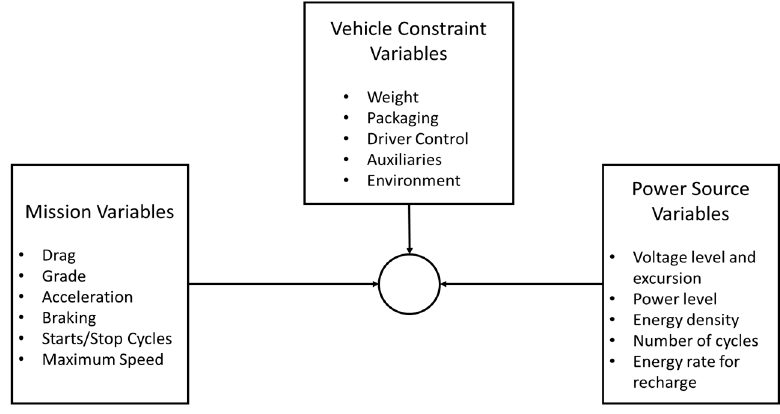
Figure 5. Power train interfaces.